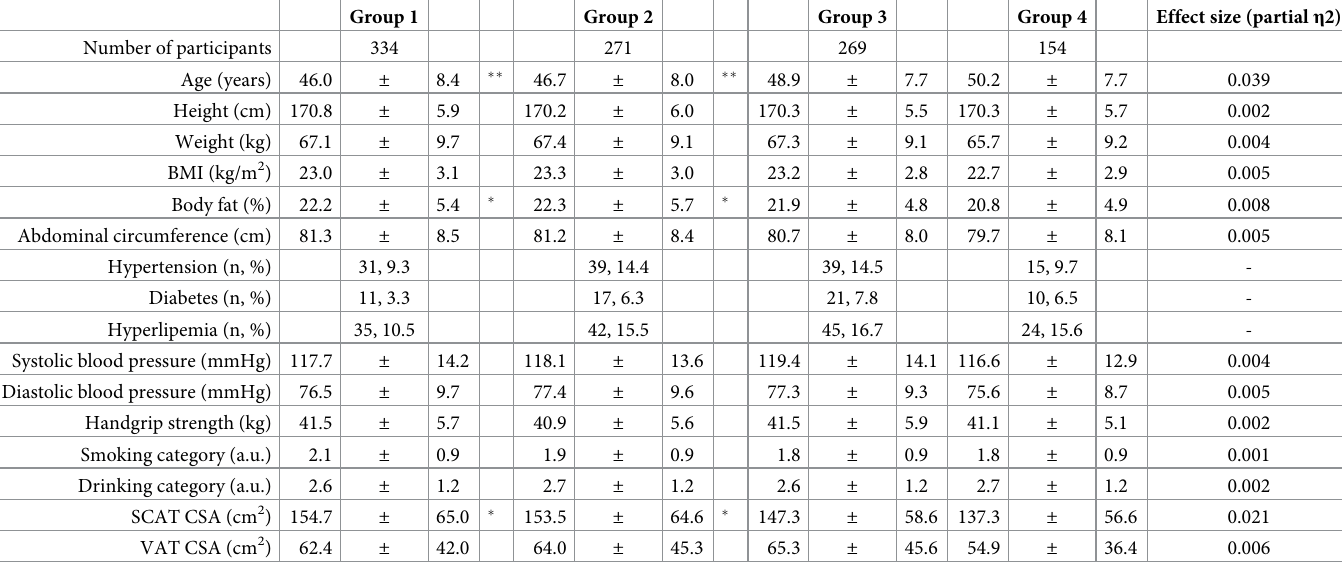
Table 1. Characteristics of